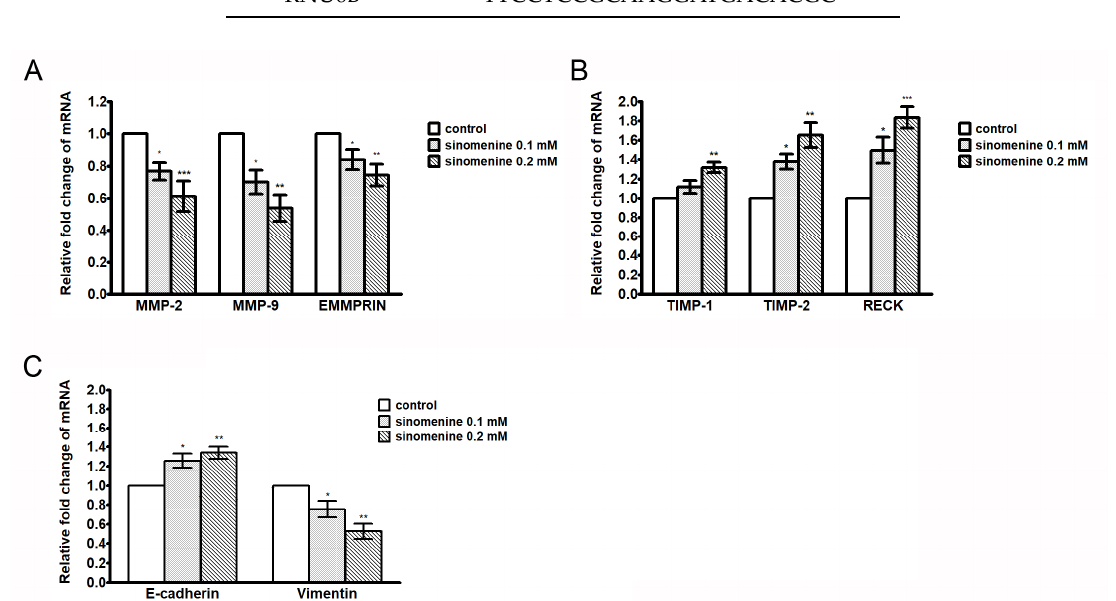
Figure 4. E ff ect of sinomenine on the expressions of MMP-2 / -9, EMMPRIN / CD147, TIMP-1 / -2, RECK, E-cadherin, and vimentin in A549 cells. Cells were treated with various concentrations of sinomenine for 24 h and the expressions of MMP-2, MMP-9, and EMMPRIN / CD147 mRNA ( A ), TIMP-1, TIMP-2, and RECK ( B ), and E-cadherin and vimentin ( C ) were analyzed by quantitative real-time PCR. Data are expressed as mean ± S.D. of three independent experiments. * p < 0.05, ** p < 0.01, *** p < 0.001 compared with the untreated control.